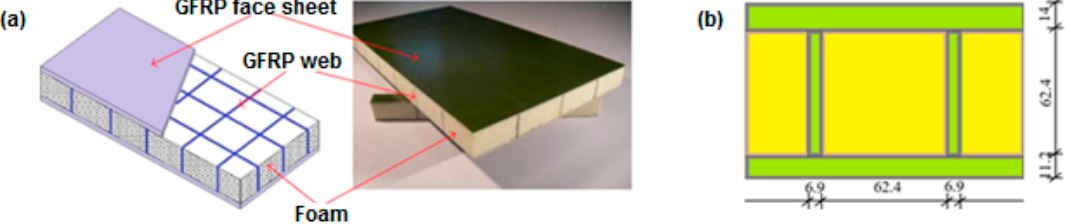
Figure 6. The innovative glass fiber-reinforced polymers (GFRP) composite sandwich slab: ( a ) the structure of the slab [40]; ( b ) the 3D model and the dimensions of the adopted composite slab [mm].